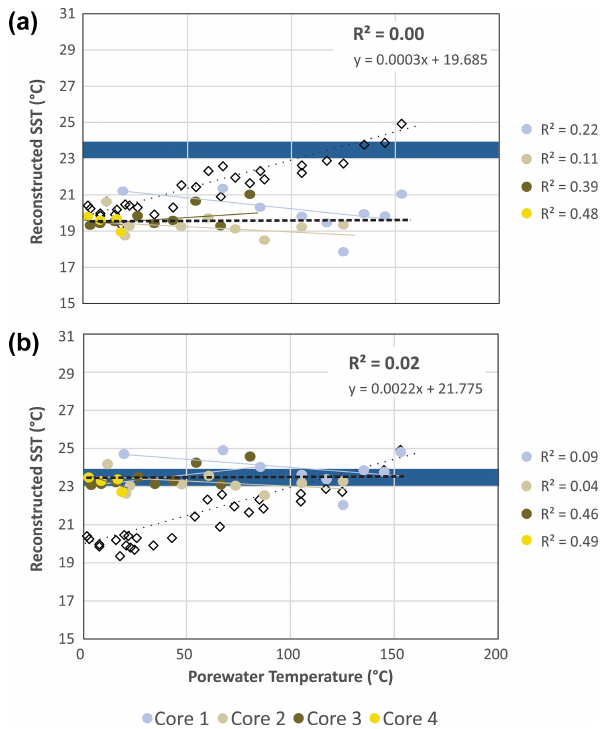
Figure 6. Reconstructed combined SS TEX 86 and SST WC TEX 86 from Eq. (4) (a) with and (b) without ϕ , K , and θ scaling parame- ters compared to measured porewater temperatures. Colored circles indicate recorded values from the four push cores. M TEX 86 val- ues are plotted for reference (open black diamonds). Blue field is the 23–24 ◦ C range observed for the 21-year (1982–2004) satellite- derived MASST data (Herrera-Cervantes et al.,